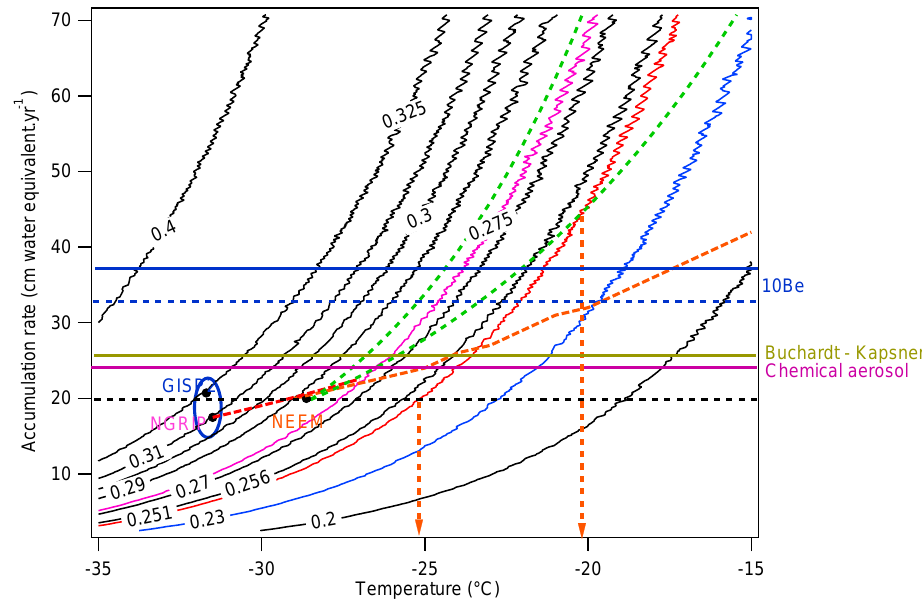
Figure 3. Contour plot showing the evolution of modeled δ 15 N with respect to accumulation rate estimates for LIG at NEEM. The black circles indicate the accumulation rate vs. temperature for preindustrial conditions for the three Greenland sites discussed here: Summit, NGRIP and NEEM. The dashed horizontal black line indicates the preindustrial level of NEEM accumulation rate; the khaki horizontal solid line stands for the maximum accumulation rate estimate from Buchardt et al. (2012) and Kapsner et al. (1995); the purple horizontal solid line stands for the NEEM deposition site LIG accumulation rate best guess estimate from chemical aerosol species; the dashed and solid blue horizontal lines show the minimum and maximum accumulation rates estimate for the NEEM deposition site at LIG proposed by Sturevik-Storm et al. (2014) on the basis of the 10 Be concentration; the red dashed curve and the green dashed curves indicate the relationship between accumulation and temperature deduced, respectively, from the P sat approach and the “Masson-Delmotte approach”. The red contour line indicates the NEEM deposition site LIG δ 15 N level excluding the peak at 2384m. The two vertical arrows indicate the highest and lowest NEEM LIG temperature as determined by the graphical determination (see text). The thin pink contour line indicates the NGRIP LIG δ 15 N level and the blue contour line indicates the GRIP/GISP2 LIG δ 15 N level. The blue circle illustrates the range of possible present-day values for GISP2 δ 15